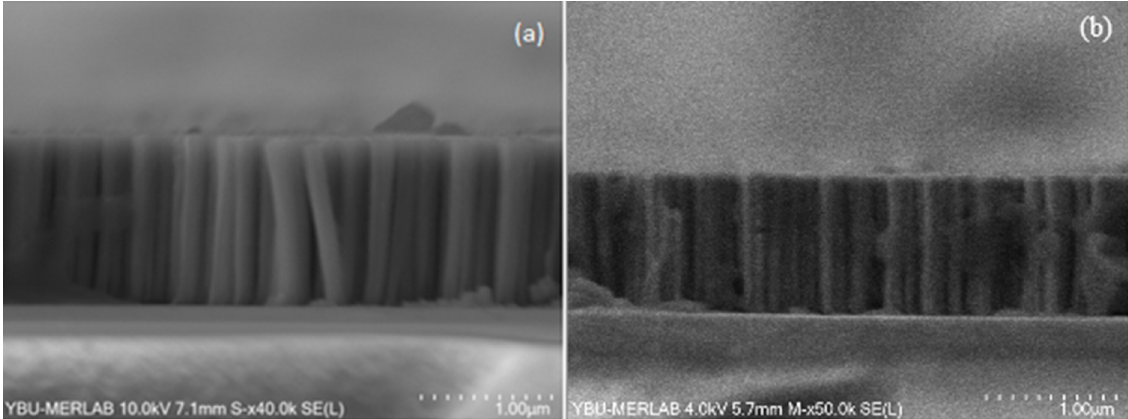
Figure 4. SEM images of catalyst surfaces after the 4th cycle ( a ) catalyst used in DMAB hydrolysis and ( b ) catalyst used in LiBH 4 hydrolysis.